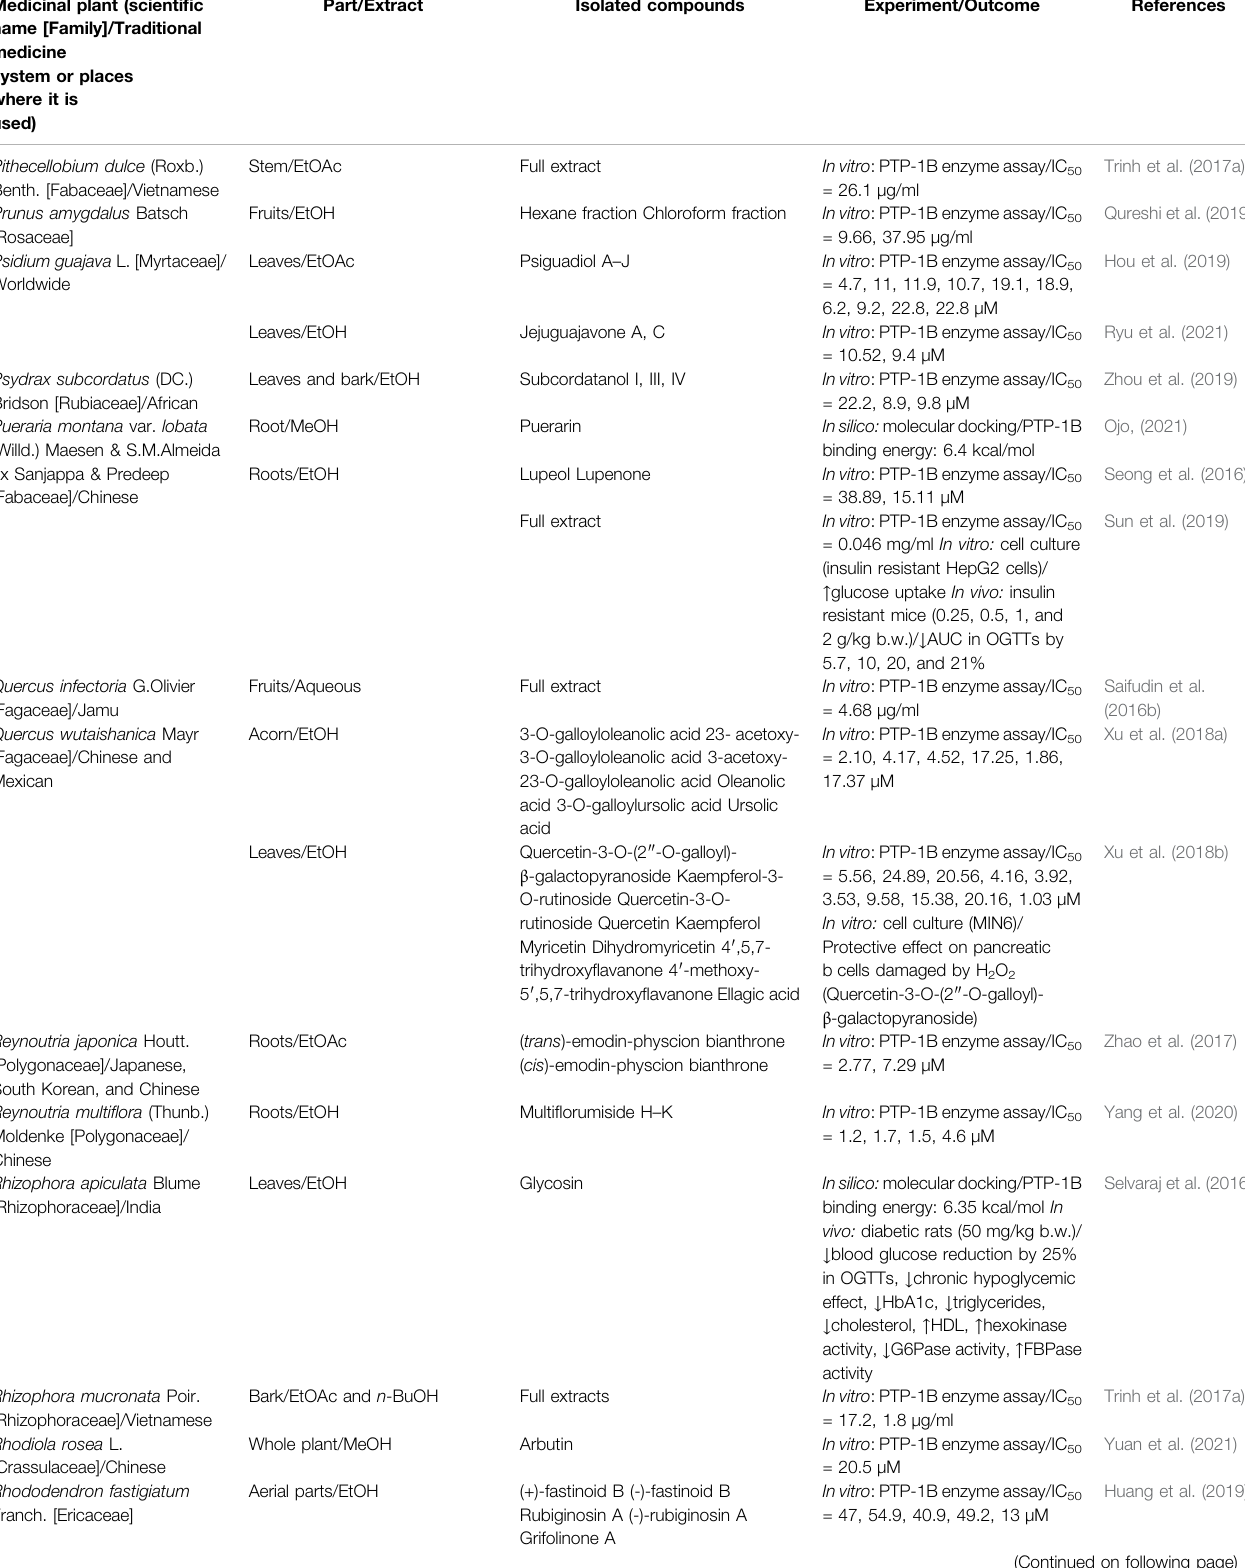
Medicinal plant (scienti fi c name [Family]/Traditional medicine system or